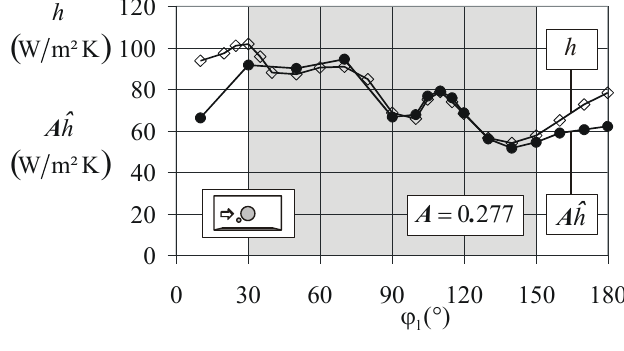
Figure 13. Triple sensor composed of three double foil sensors ( 1  4; 2  5; 3  6 );